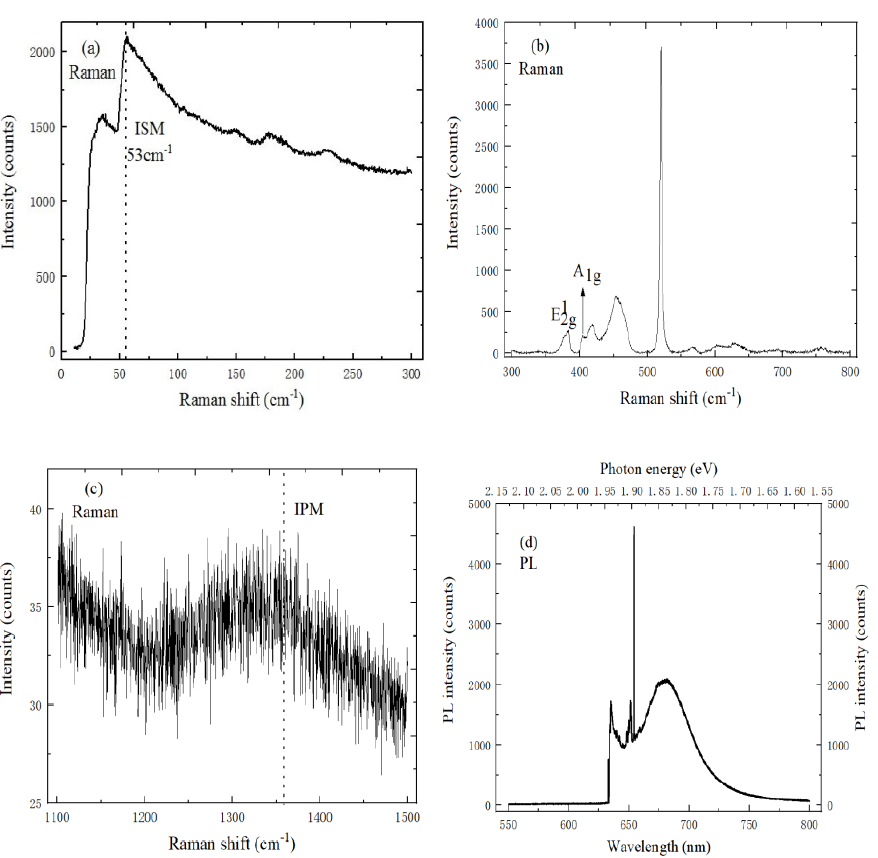
Figure 5. Spectral characteristics of MoS 2 /h-BN heterostructure. ( a ) ISM mode characteristic peak of h-BN (10 mW, 633 nm), ( b ) E 1 2g and A 1g mode characteristic peak of MoS 2 (10 mW, 633 nm), ( c ) IPM mode characteristic peak of h-BN (10 mW, 633 nm), ( d ) PL spectrum of MoS 2 /h-BN heterostructure (20 mW, 633 nm).